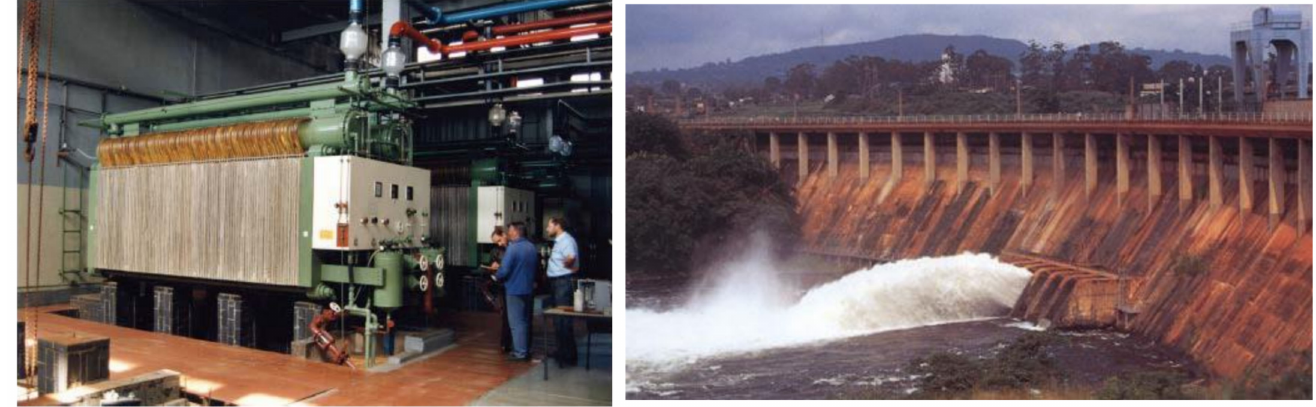
Figure 8. Left: Electrolyzers in the Aswan ammonia factory in Egypt, constructed in 1960. Reproduced from reference [43]. Right: Aswan Dam. Reproduced from reference [43]. Courtesy University of